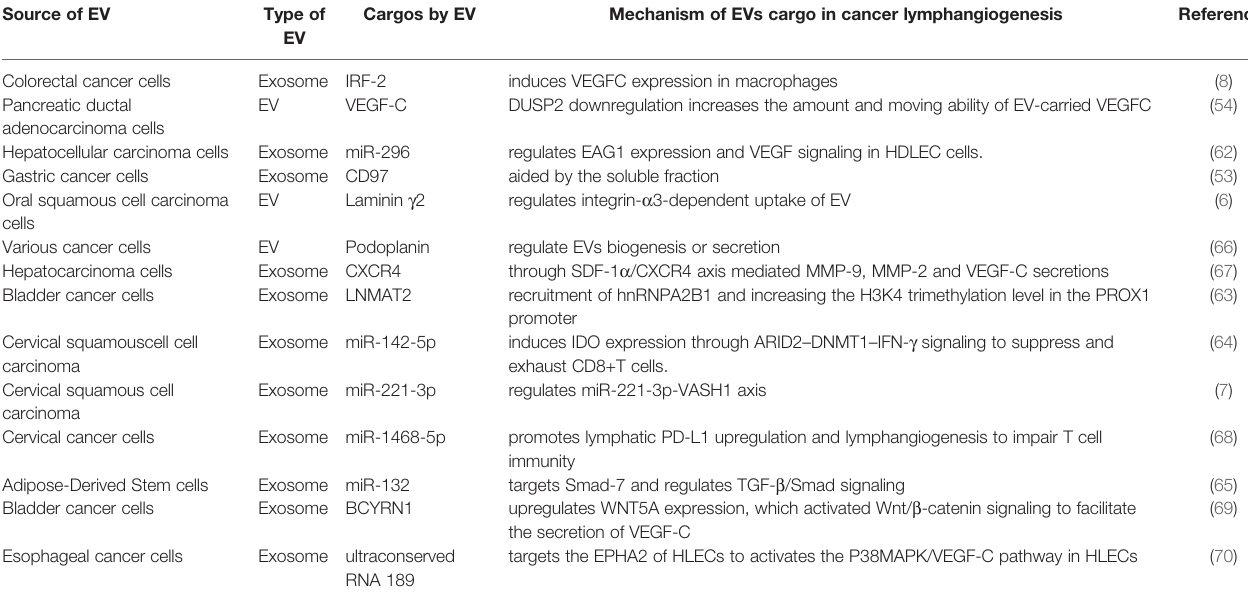
TABLE 1 | The role of EVs in tumor induced lymphangiogenesis. Source of